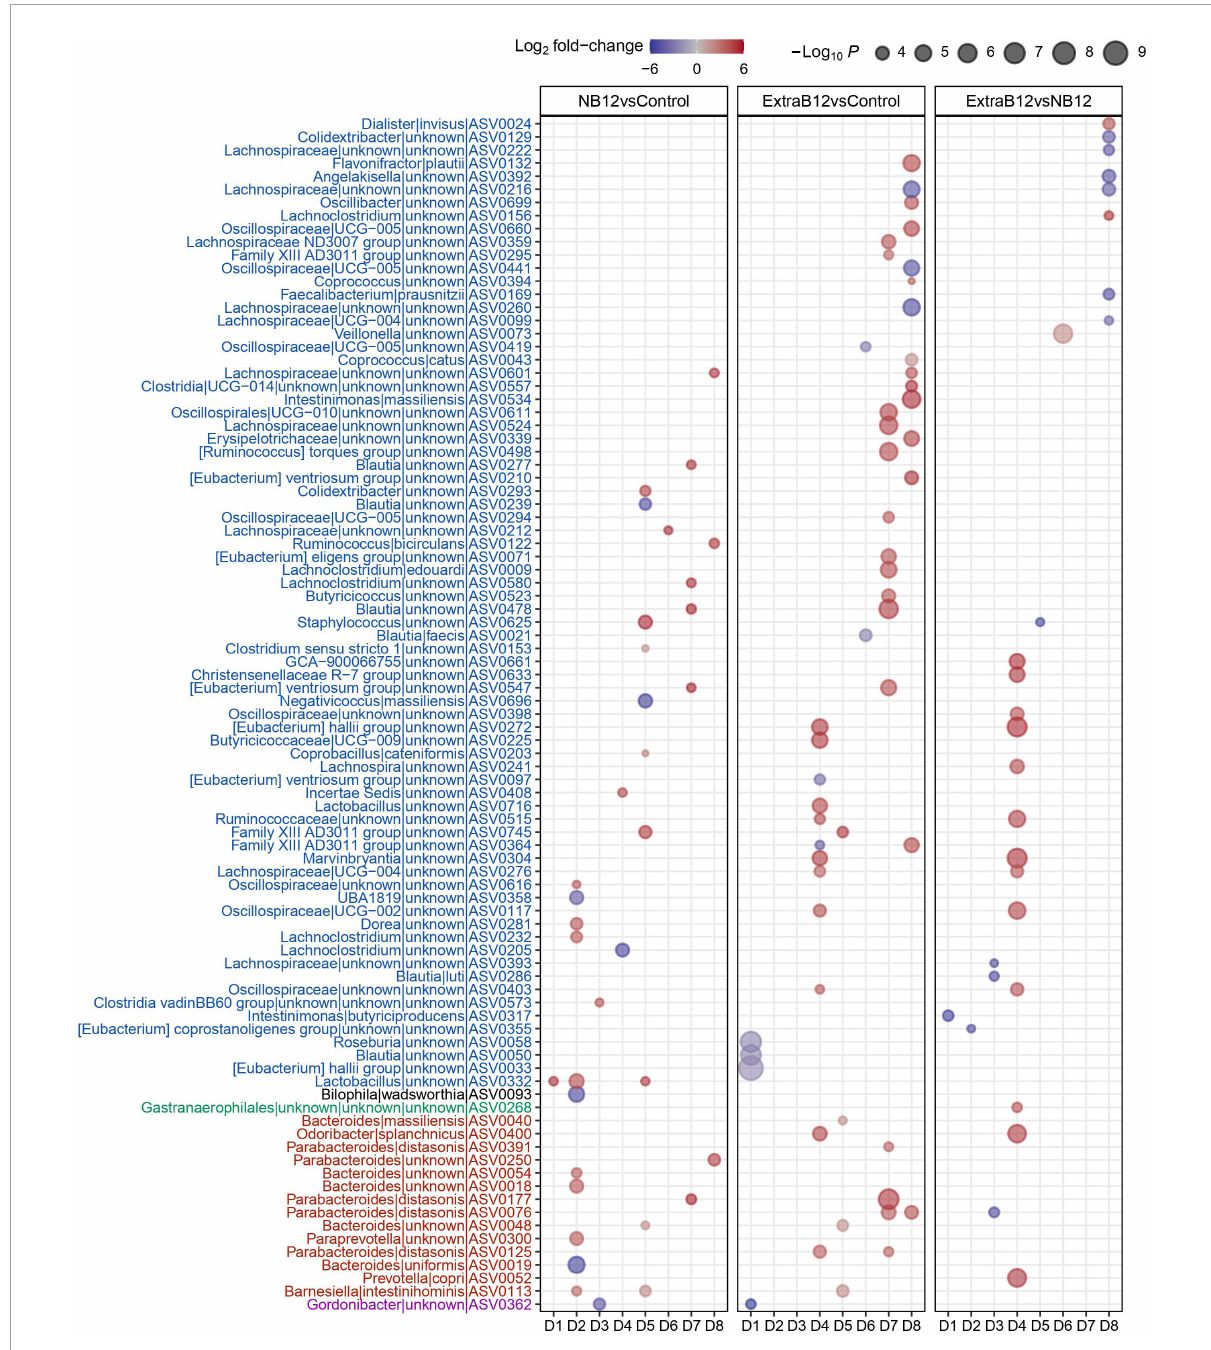
FIGURE5 Dot plot of top differentially abundant ASVs between the different batch fermentation conditions per fecal donor microbiota selected based on log 2 fold change and P -value ( < 0.001). The color of the dot represents the change (blue indicates a decrease in the treatment; red indicates an increase in the treatment), and the size of the dot represents the significance, the bigger the size, the higher the significance is. The x-axis represents the donors (D1–D8), and the y-axis represents the different genus and ASVs grouped by phyla, into different colors (Blue = Firmicutes , Black = Desulphobacteria , green = Cyanobacteria , red = Bacteroidetes , and pink = Actinobacteria ).